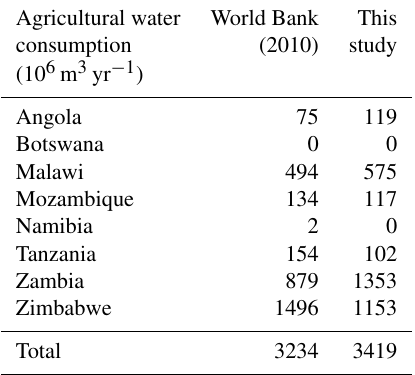
Table 6. Agricultural water consumption in the Zambezi River